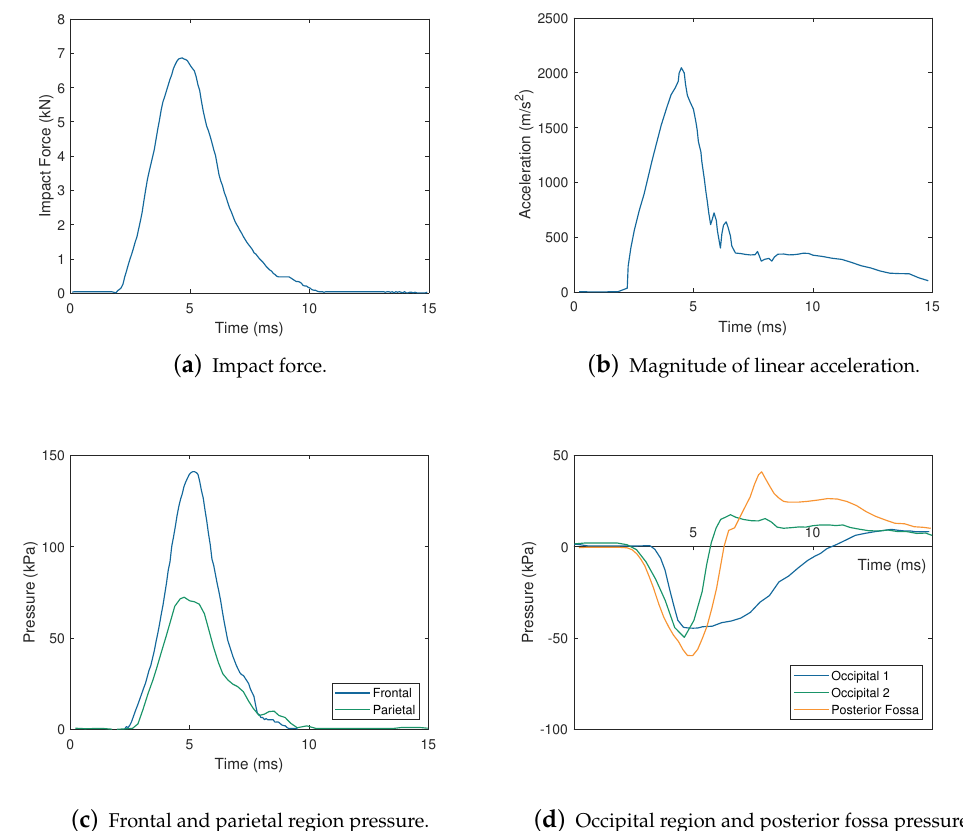
Figure 1. Cadaver response to impact during experiment 37 (adapted from Nahum et al. [34]). Extracranial response: ( a ) impact force history at the frontal impact location and ( b ) resultant linear acceleration. Intracranial pressure response: ( c ) pressure response in the frontal and parietal regions, measured by transducers fixed in the sub-dural region and ( d ) bilateral intracranial pressure in the occipital region, measured by transducers fixed in the sub-dural region and pressure response recorded by transducer in the